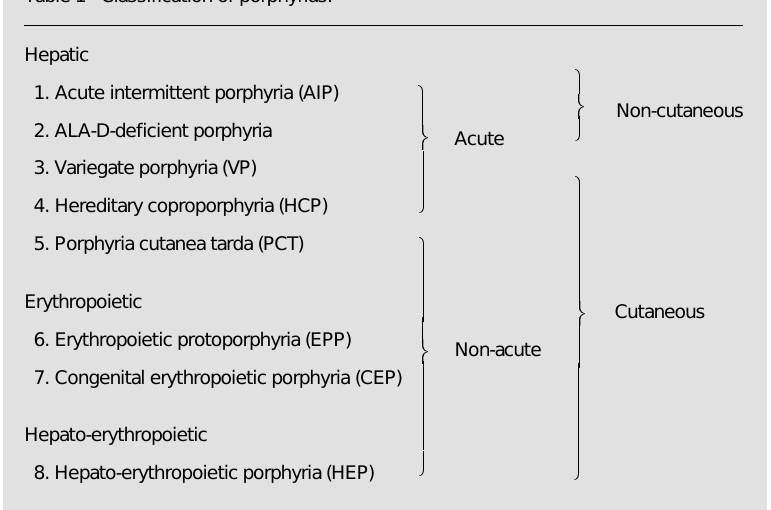
Table 1 - Classification of porphyrias.